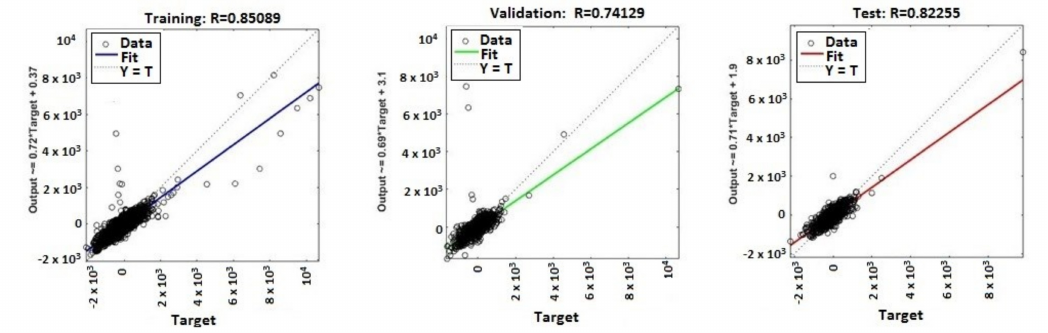
Figure 11. Regression ( R 2 ) for validation, test, and training—ANN with 100